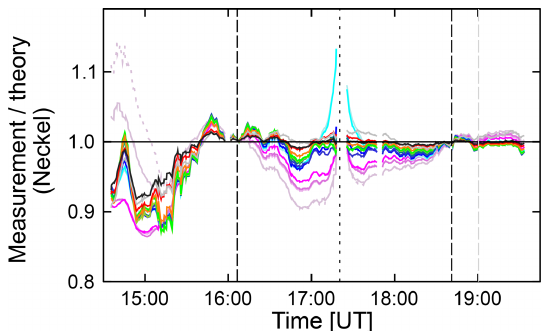
Figure 9. Similar to Fig. 8d, but with theoretical LD effect parame- terized based on Neckel instead of Pierce.